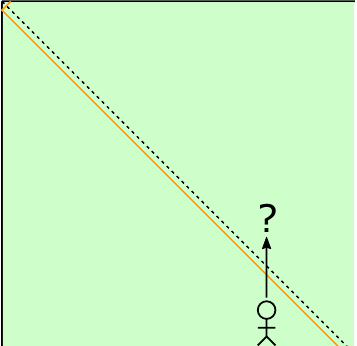
Figure 15 . A puzzling situation: an AdS black hole is in a state where at some time in the distant future, a thermal scale shell (or for that matter a bullet) will definitely come out. What happens to an observer who jumps in now? Classically they experience a high-energy collision, but do they really? A “stretched horizon” picture would instead suggest that the shell does not exist until it crosses a surface roughly a Planck distance outside of the